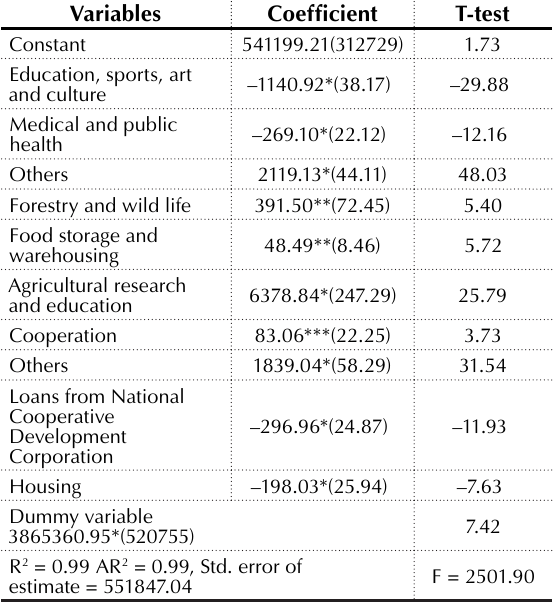
Table 12. Regression for capital